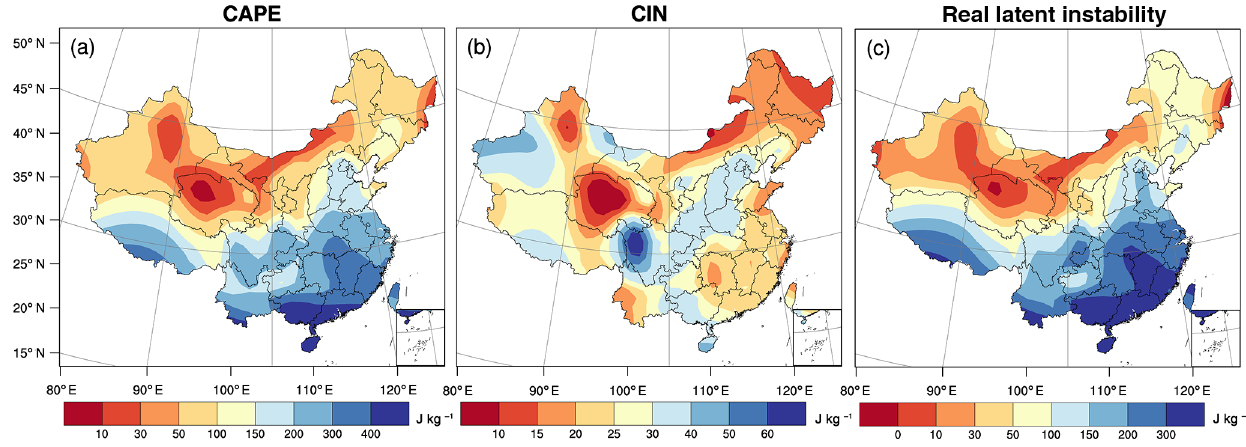
Figure 7. The spatial distribution of annual mean CAPE (a) , CIN (b) , and real latent instability (c) during